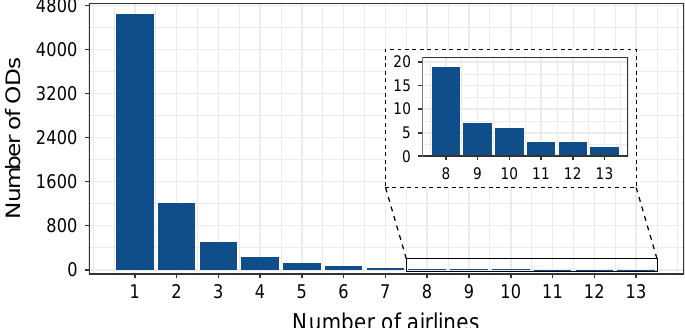
Figure 3. Number of airlines serving ODs with GCD lower than